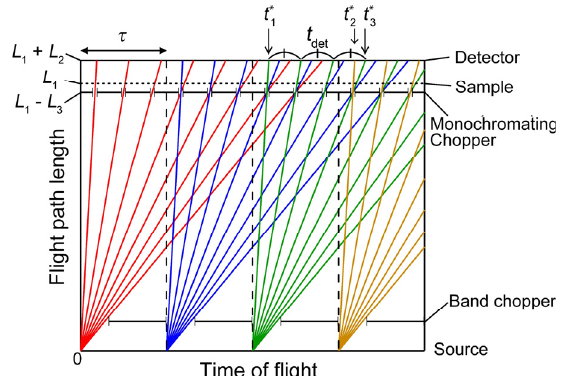
Fig. 3. Example of the case to obtain E i s arriving at the detector position at a regular interval. In this figure, the combination of parameters n f = 3, n i = 3, n p = 8, and n d = 1 is considered. Detail can be seen in the text. E i s from the time < 0 are omitted in the figure.